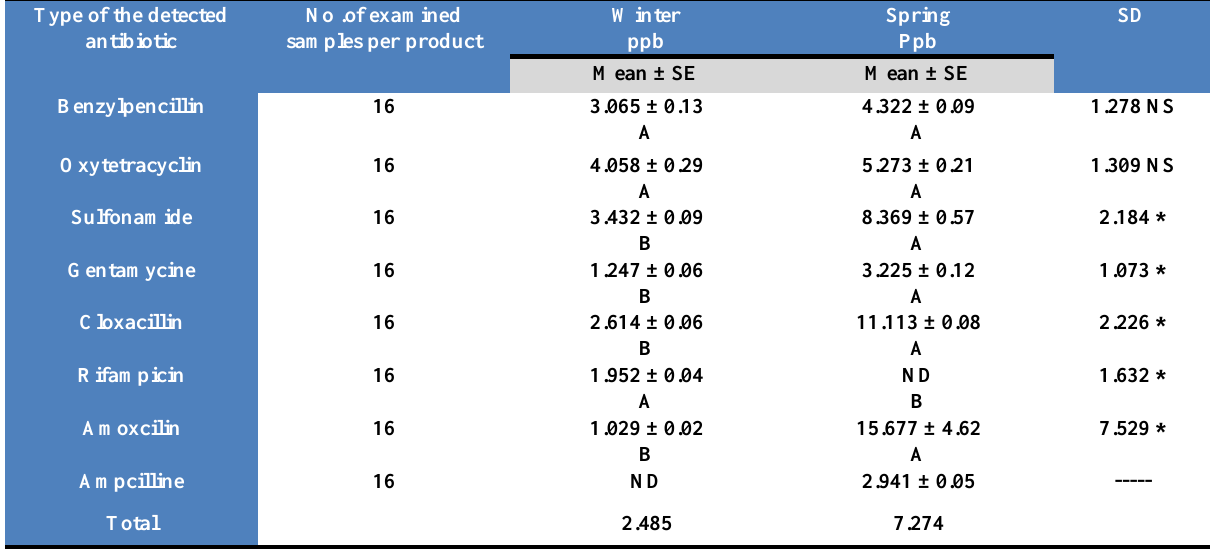
Table, 2: Seasonal variation of the mean levels of residual concentration (ppb) for each of the eight different antibiotics in milk samples collected from all milk storage tanks.